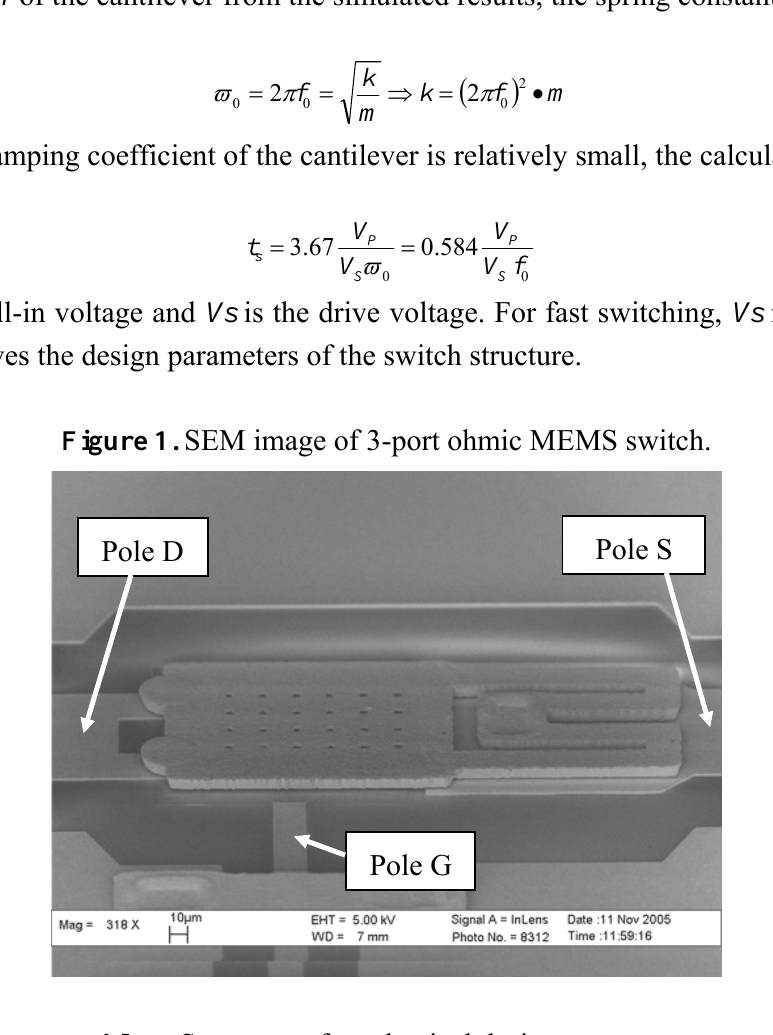
Table 1. Summary of mechanical design